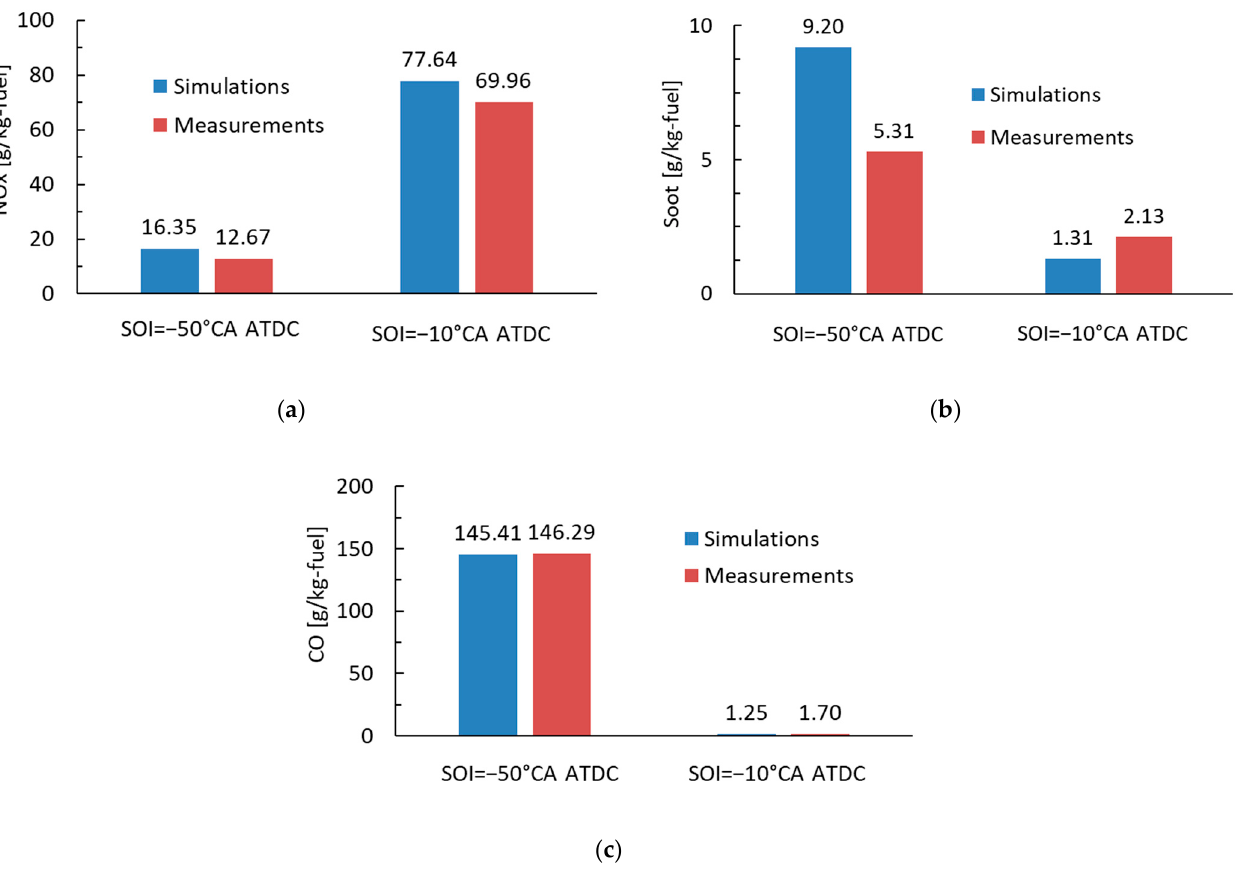
Figure 7. Comparison of calculated and measured engine-out ( a ) NO x ; ( b ) soot; ( c ) CO emissions.